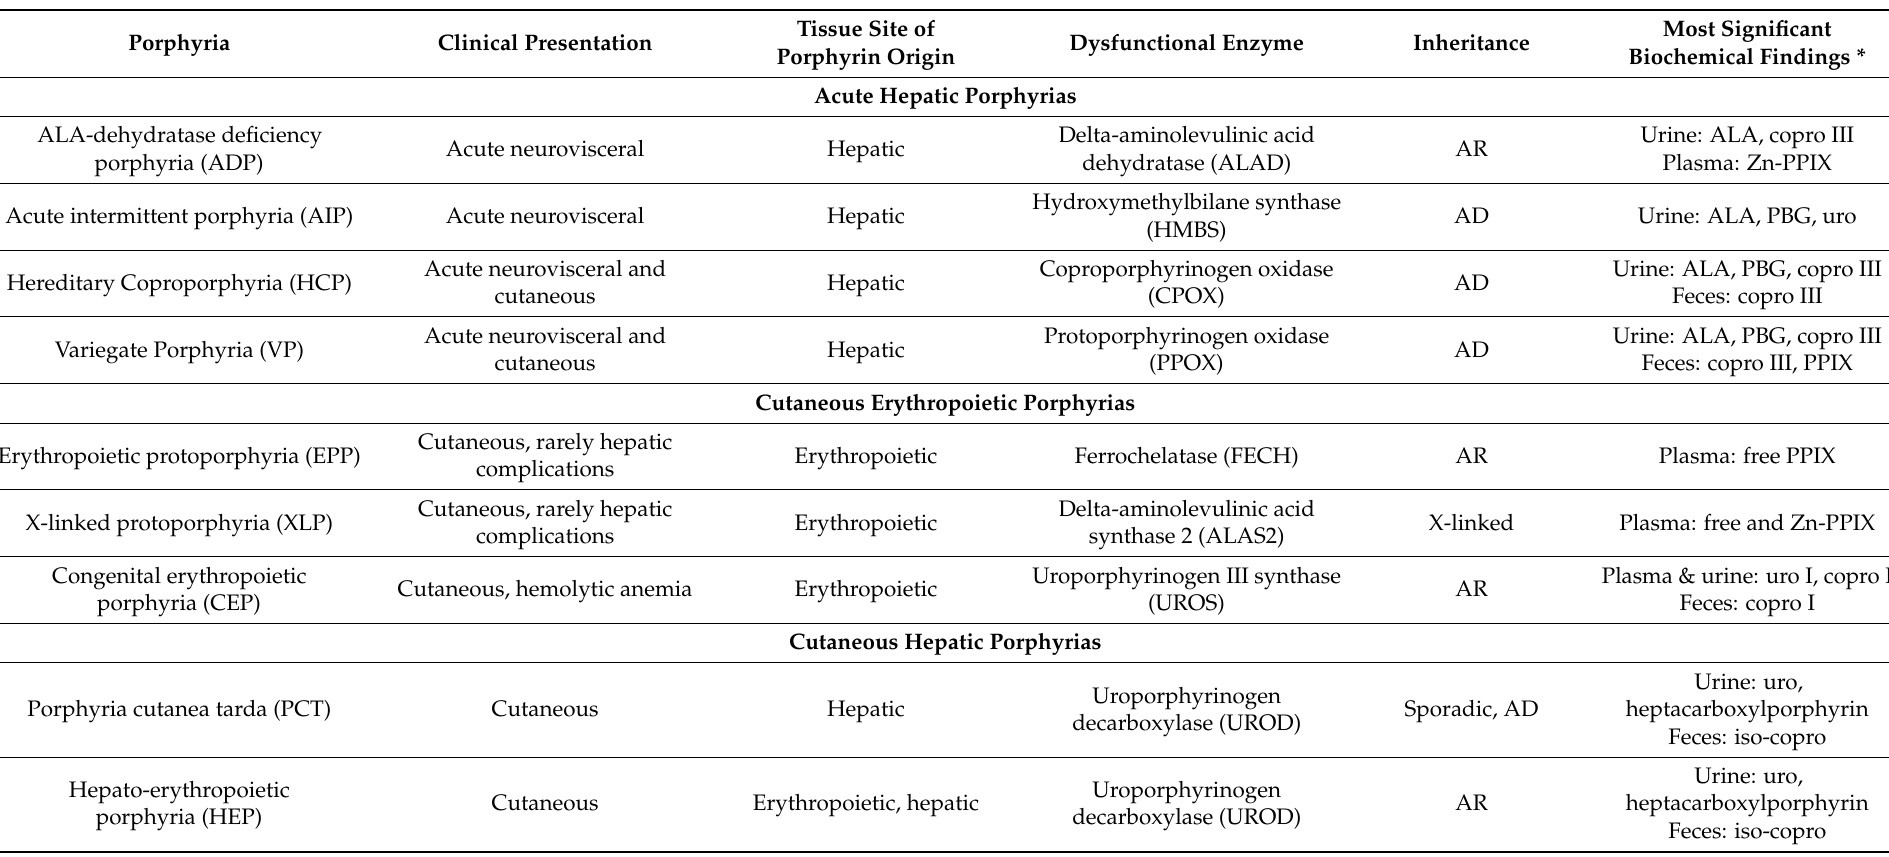
Table 1. Overview of the different porphyrias with respect to certain distinguishing key elements, affected enzymes, inheritance patterns and most common biochemical porphyrin